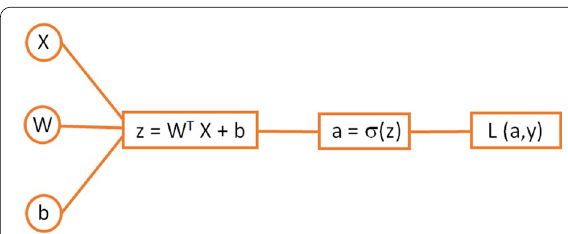
Fig. 7 Forward propagation of a single